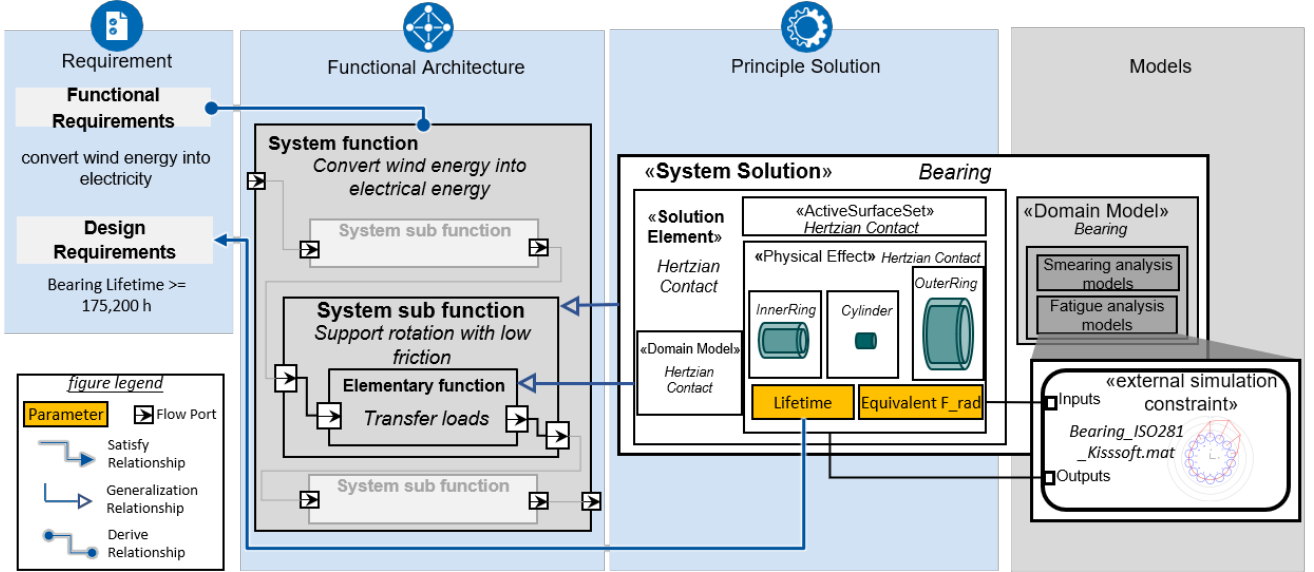
Figure 1. Interconnected function, solution, and domain model architecture within a system model. Adapted from [6].